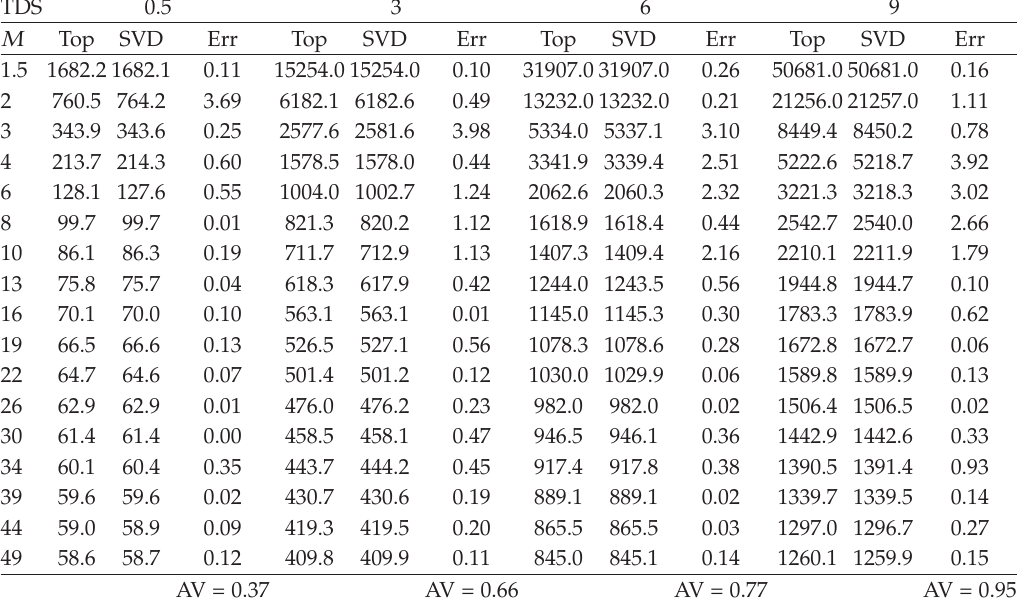
Table 5: The curve-fitting errors of 17 actual operating times for each TDS of the CO-8 relay in milliseconds.